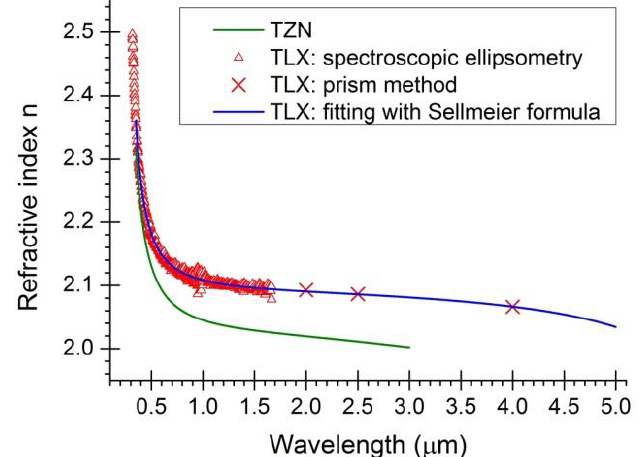
Figure 5. Refractive index curves of TZN and TLX